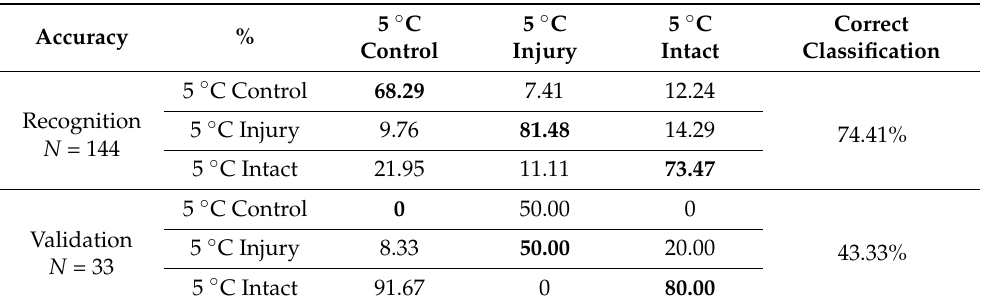
Figure 3. PCA-LDA classification model on the NIRS data of control and infected plums from measurement day 8 with external validation when the inoculation mode was used as class variable: ( a ) PCA-LDA of samples stored at 5 °C ( N = 177, and NrPCs = 16); ( b ) PCA-LDA of samples stored at 24 °C ( N = 180, and NrPCs = 10). Table 3. PCA-LDA classification model on the NIRS data of control and infected plums stored at 5 °C with 5th parallel sample data validation when the inoculation mode was used as class variable ( N = 177, and LV = 16).